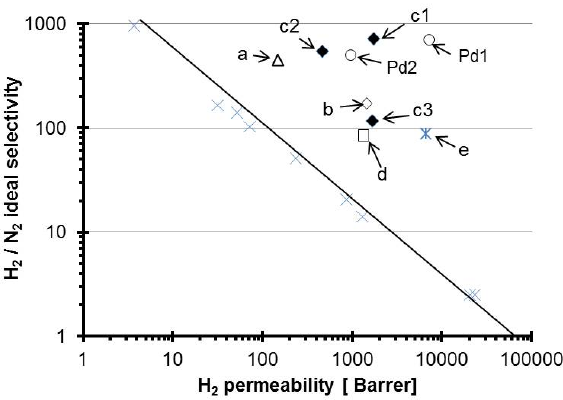
Figure 4. Robeson upper bound plot for H 2 /N 2 for: ( a ) Campo [68] , ( b ) Tseng [69], ( c1 ) Llosa [51], ( c2 ) Llosa [51], ( c3 ) Llosa [51], ( d ) Hosseini [70], ( e ) Zhou [71], ( Pd1 ) Pacheco, Pd pore‐filled membranes at 100 °C [72], and ( Pd2 ) Pacheco, Pd pore‐filled membranes at 50 °C [72].